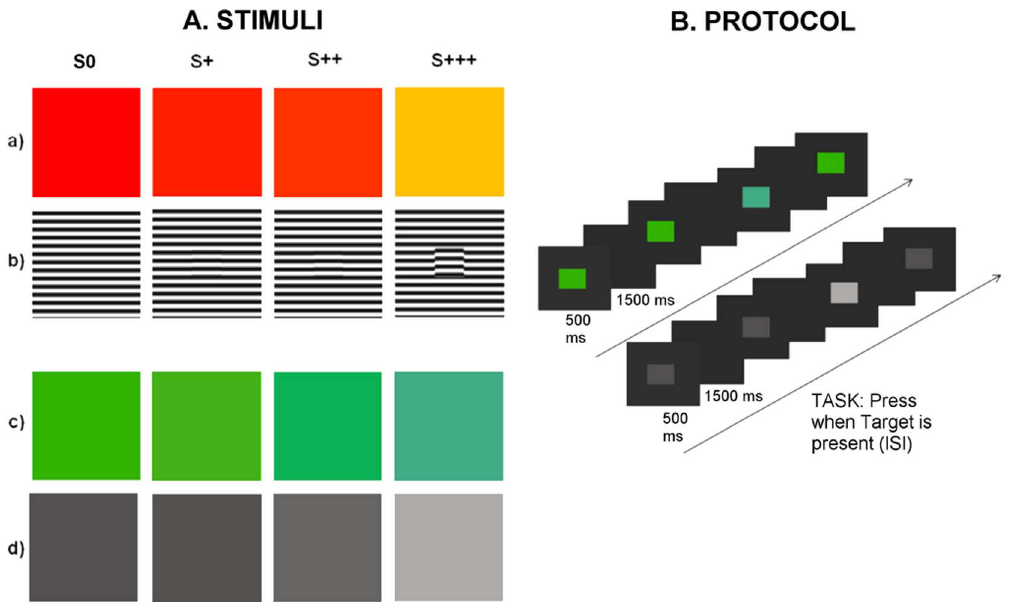
Figure 1. Examples of frequent standard stimuli (leftmost) and rare detection targets (3 rightmost). Manipulation of physical and perceptual saliency was imposed in 4 different experiments: A. Mixed color/luminance (a) and phase offset (b) chrominance (c) and luminance (d). Subjects were required to report the presence of a target as manifested by detectable categorical deviances from the standard stimuli. Stimulus physical properties are described in the text (appearance maybe different from the actual display due to issues such as color rendering, size and resolution). B. Experimental protocol (identical in all experiments and therefore only shown for the monotonic saliency manipulations of chrominance and luminance). Oddball: for each experimental condition - 20 blocks of 50 trials with sequentially displayed Standards (S0) and randomly allocated Targets (S + ,S ++ and S +++ ), with a target frequency ratio of 1:16 (47 ST/3T). Total target presentation number: 20. Stimuli were displayed for 500 ms, with an Inter Stimulus Interval (ISI) of 1500 ms. ISI: grey blank screen with identical colorimetric properties to stimuli’s background. Task: press a button during the ISI when Target is present.